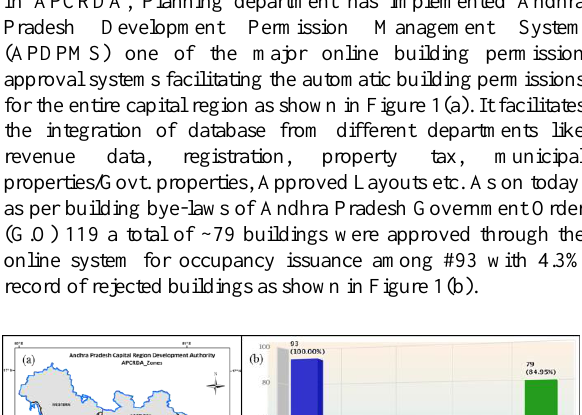
Figure 2: Construction monitoring in the dense urban area using drone survey at two time intervals.